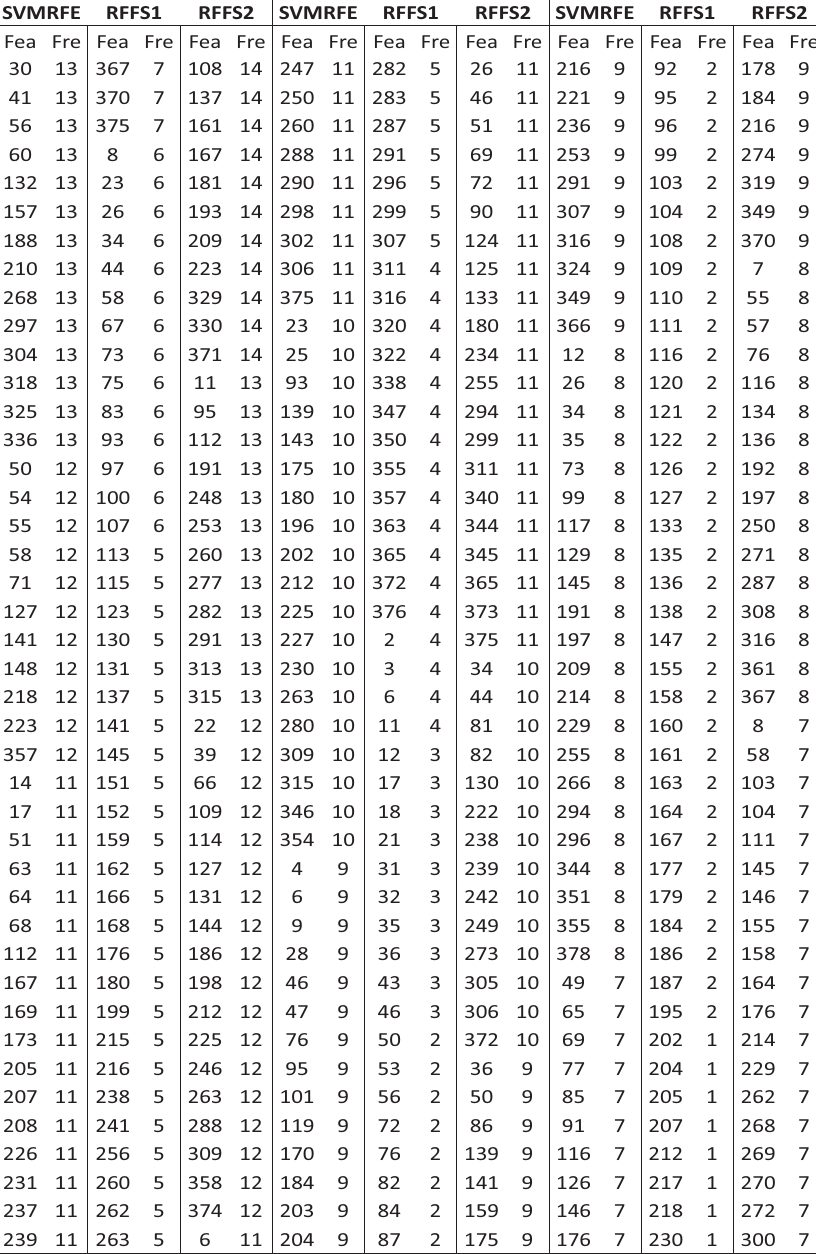
Figure A6. SVMRFE and RFFS results of FNC data, Part